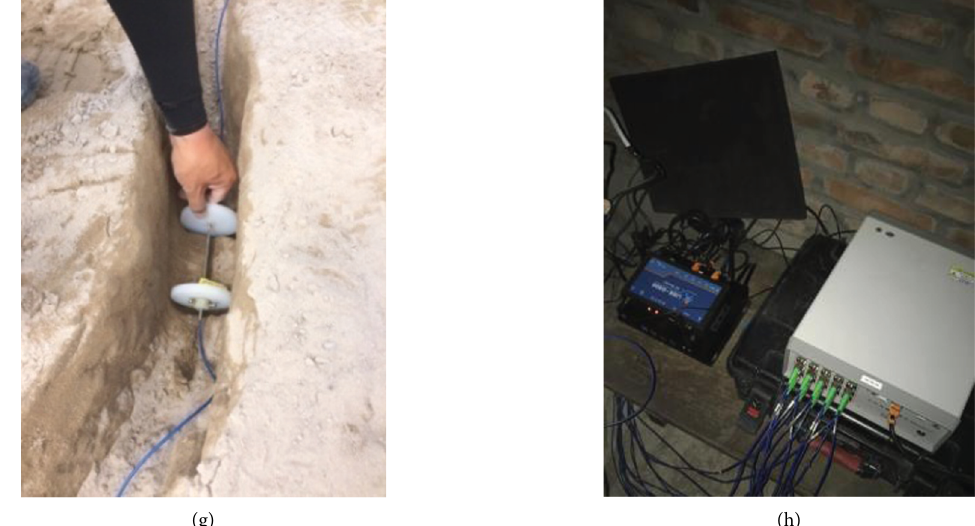
Figure 3: Temperature, humidity, and deformation sensors embedded in the test roadbed soil and data collection terminal. (a) Buried groove excavation, (b) fiber optic cable layout, (c) humidity sensor, (d) burying of humidity sensor, (e) humidity sensor data collection terminal, (f) fiber grating (temperature) strain sensor, (g) embedded fiber grating (temperature) strain sensor, and (h) strain sensor data acquisition